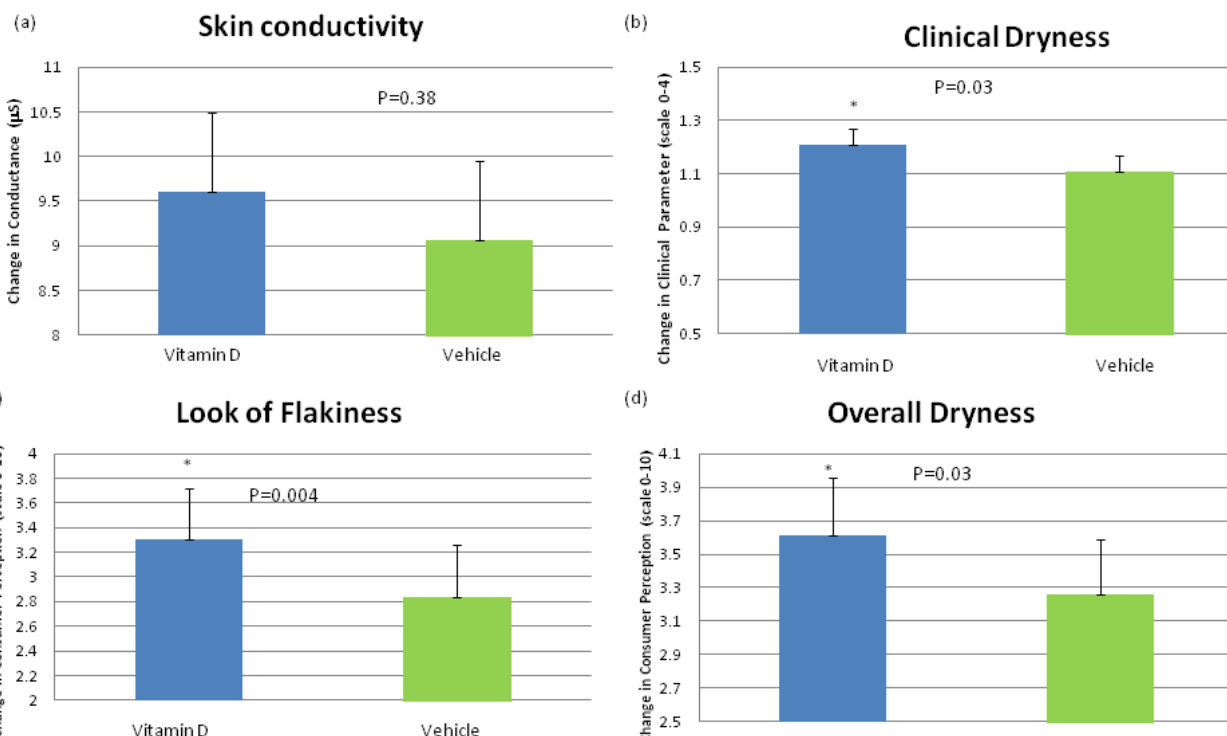
Figure 2. Mean change at week 3 from baseline for ( a ) skin conductivity; ( b ) clinical grading of visual dryness; ( c ) subject perception of visual skin dryness; and ( d ) subject perception of overall dryness. A subset of non-sufficient-vitamin D (OH) serum subjects was analyzed. The addition of vitamin D to a moisturizing formula significantly (Wilcoxon Signed Rank Test, p < 0.05) improved clinical grading of visual dryness and consumer perception of flakiness and dryness over the moisturizing formula alone. There was a trend in vitamin D over the vehicle in skin